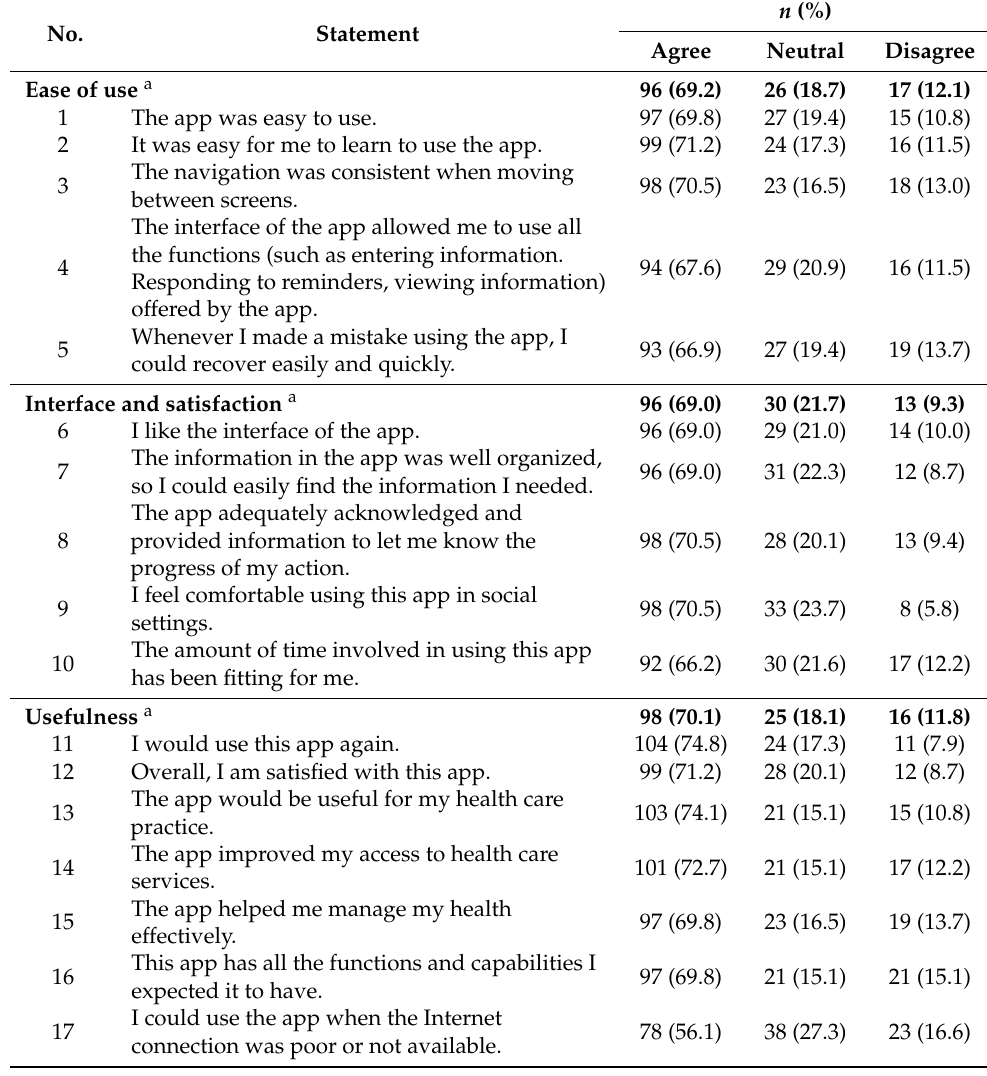
Table 2. Acceptance response based on the mHealth App Usability Questionnaire (MAUQ) and recommendation ( n =